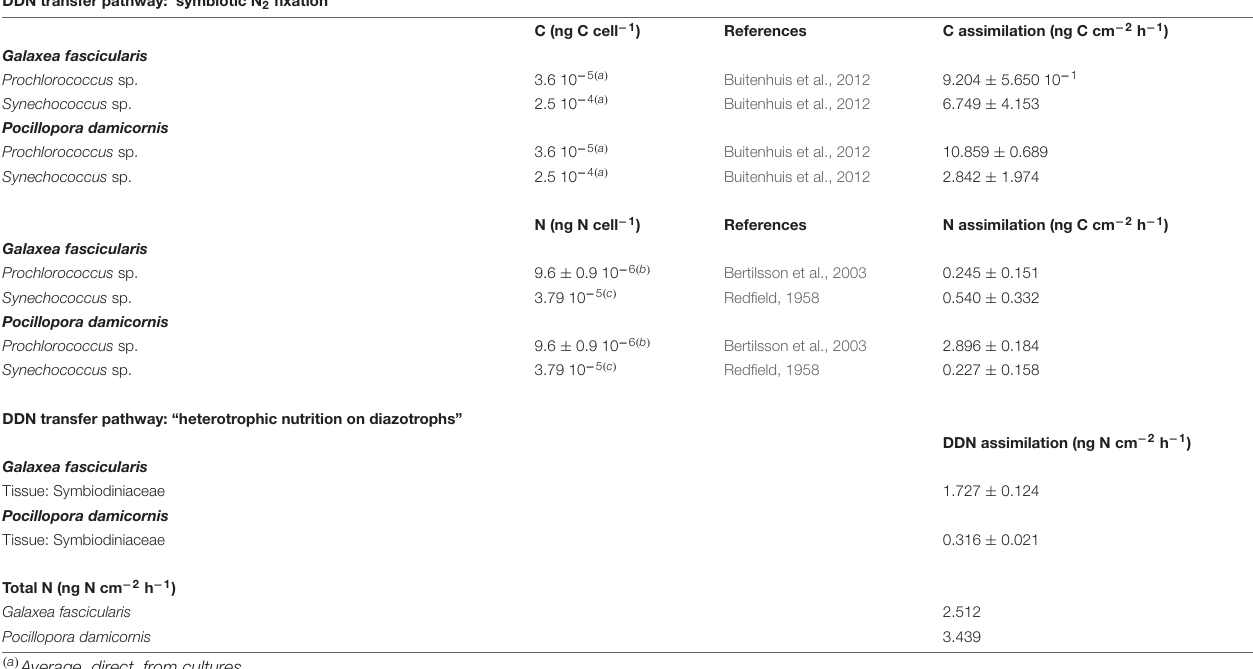
TABLE 1 | Carbon and nitrogen cell content (ng cell − 1 ) and related N assimilation rates ( µ g cm − 2 h − 1 ) calculated for Prochlorococcus , Synechococcus using literature conversion factors and the results of the present study (mean ± SE). DDN transfer pathway: ‘symbiotic N 2 fixation’